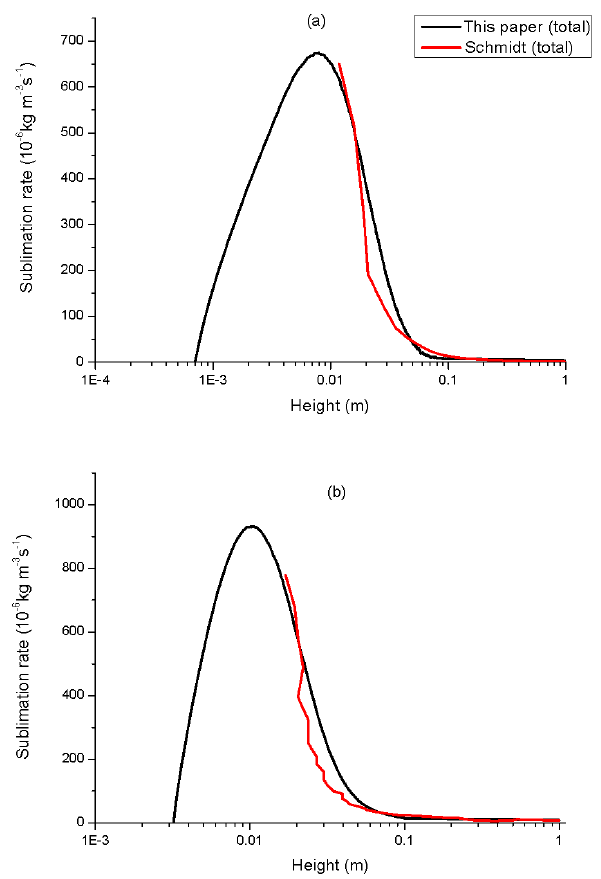
Figure 3. Comparison of sublimation rate obtained this paper and by Schmidt (1982) (a) u ∗ = 0 . 632ms − 1 , T = 267 . 45K; u ∗ = 1 . 072ms − 1 , T = 265 . 65K). The results marked by the red line are from the data observed by Schmidt (1982) in Wyoming, USA, in 1982.